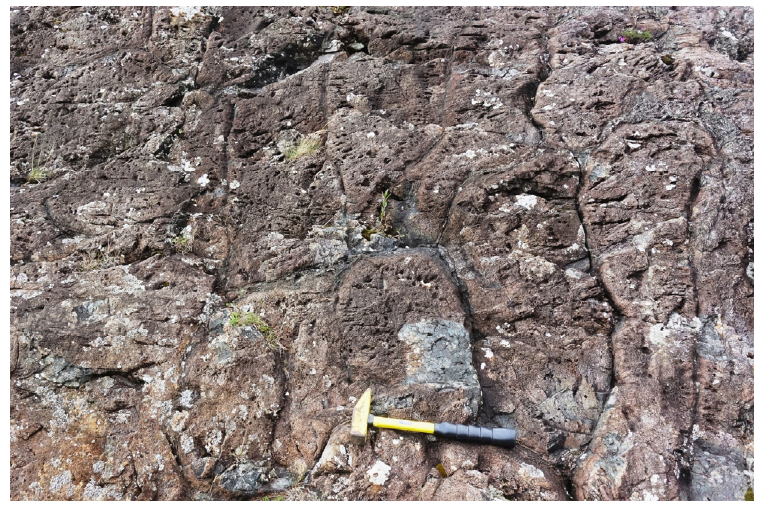
Figure 3. Finny, County Mayo: roadside outcrop of Ordovician pillow lavas.